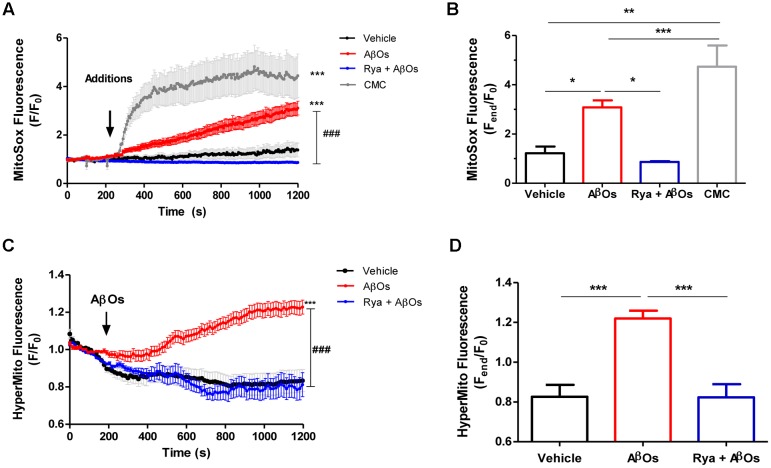
The increased mitochondrial hydrogen peroxide and superoxide levels induced by AβOs require Ca2+ signals mediated by RyR. Hippocampal neurons were loaded with MitoSOXTM, which is a fluorescent superoxide sensor, specifically targeted to mitochondria, or were transfected with the plasmid HyperMito, which encodes a fluorescent protein specifically targeted to mitochondria that acts as a hydrogen peroxide sensor. (A) Time course of MitoSOXTM fluorescence responses recorded before and after addition of 500 nM AβOs to neurons pre-treated with Ryanodine 50 μM for 1 h (blue trace) or to untreated neurons (red trace). The arrow indicates the time of the addition of AβOs, or of the specific RyR agonist 4-CMC (1 mM, green trace), or vehicle (black trace). Changes in fluorescence, plotted as signal over time with respect to the baseline fluorescence (F/F0), were expressed as mean ± SE. (B) Changes in MitoSOXTM fluorescence, plotted as the signal obtained at the end of the experiment (1200 s) with respect to the baseline fluorescence (Fend/F0), were expressed as mean + SE for all the experimental conditions. (n = 6 for Control, n = 7 for AβOs, n = 6 for Rya + AβOs, n = 7 for CMC). (C) Time course of HyperMito fluorescence responses recorded before and after addition of 500 nM AβOs to neurons pre-incubated with Ryanodine 50 μM for 1 h (blue trace) or to control neurons (black trace). The arrow indicates the time of the addition of AβOs or vehicle. For each condition, ROIs were defined in 1 to 3 neurons per field in order to monitor the production of superoxide or hydrogen peroxide levels in the mitochondria. The experiments were repeated in triplicate using at least three different cultures (n ≥ 3). Changes in fluorescence, plotted as signal over time with respect to the baseline fluorescence (F/F0), were expressed as mean ± SE. (D) Changes in HyperMito fluorescence were plotted as the signal obtained at the end of the experiment (1200 s) with respect to the baseline fluorescence (Fend/F0) and expressed as the mean + SE for all the experimental conditions. (n = 20 for Control, n = 32 for AβOs, n = 10 for Rya + AβOs). Statistical analysis was performed using one-way ANOVA followed by Bonferroni post hoc test. ∗p < 0.05, ∗∗p < 0.01, ∗∗∗p < 0.001 compared with control. ###p < 0.001 compared to AβOs-treated neurons.